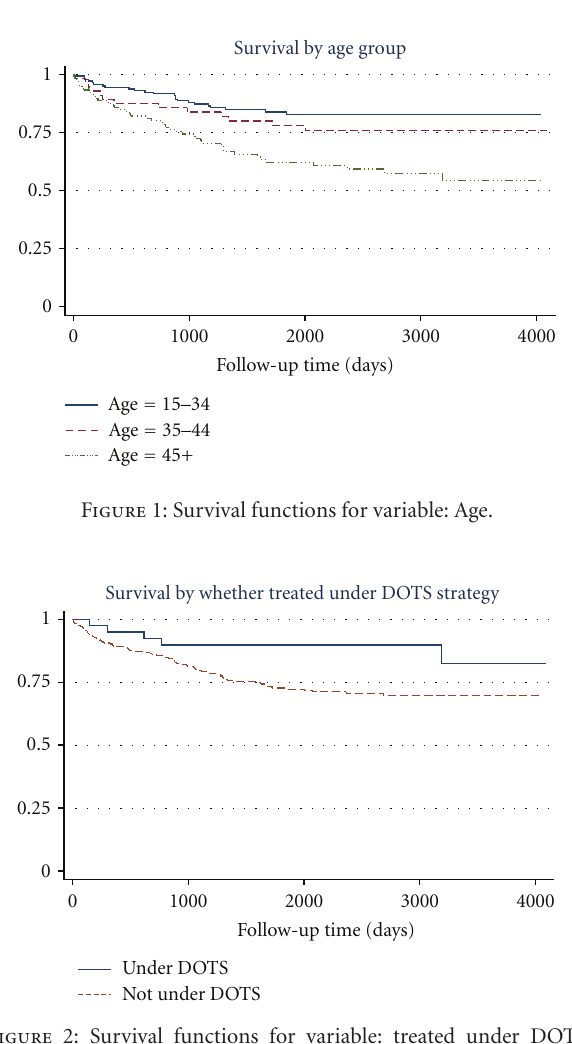
Figure 2: Survival functions for variable: treated under DOTS strategy.